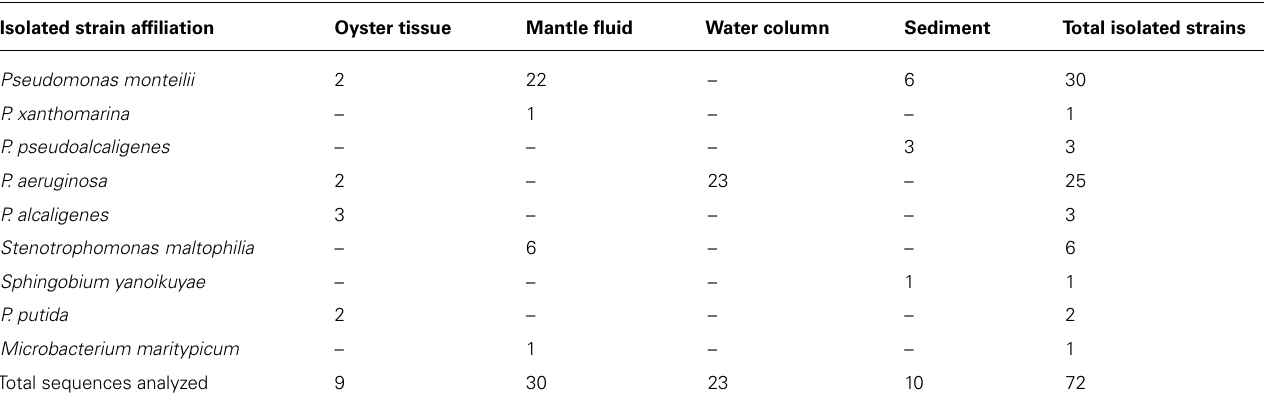
Table 2 |Taxonomic affiliation shown of the 72 oil-degrading bacterial strains that were isolated from DWH oil-amended microcosms containing oyster tissue (OT), mantle fluid (MF), water column (WC), and sediment (S) samples obtained from Dry Bar,Apalachicola Bay, FL, USA. Isolated strain affiliation Oyster tissue Mantle